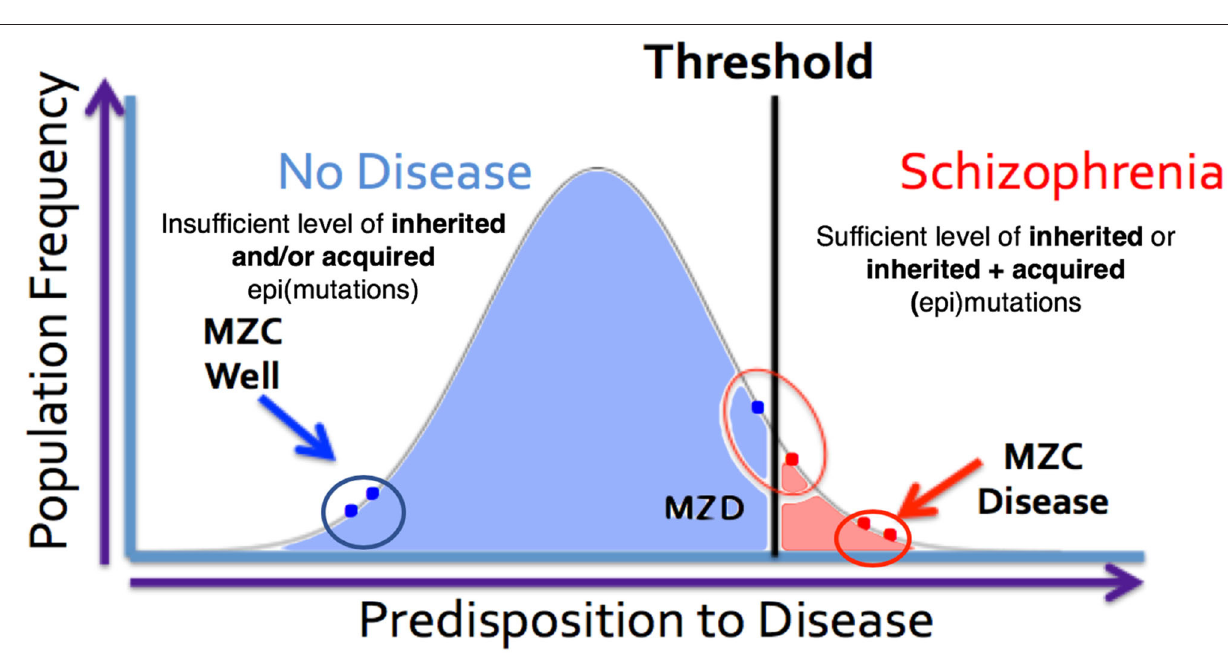
FIGURE 4 | MZ twins as a model for assessing the genetic threshold liability hypothesis. Representation of three sets of twins [MZC well (monozygotic twins both unaffected), MZC disease (monozygotic twins both diseased) and MZD (monozygotic twins discordant)] within the threshold liability hypothesis (unaffected = blue, disease affected = red). In this model, the affected twin in the MZD pair must acquire somatic mutation/epimutation to cross the threshold and develop the disease. Genomic and epigenomic assessment of these exceptional twin pairs will allow for identification of pair-specific postzygotic somatic event(s) [Adapted from Castellani et al. (88,